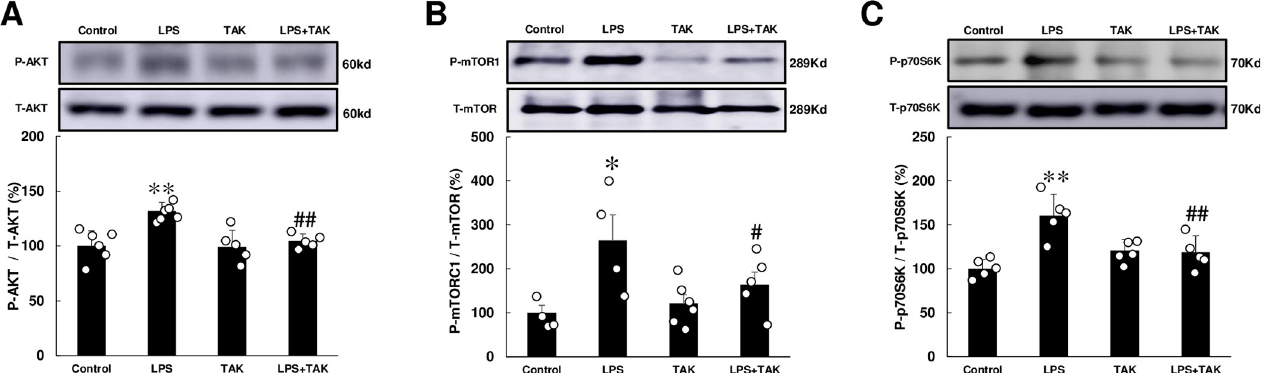
Fig 6. Effects of chronic PG-LPS infusion on Akt, mTOR, p70S6K, LC3, p62 in the heart. (A) Akt phosphorylation (Ser-473) was significantly increased in the PG-LPS group, and this increase was significantly attenuated by TAK-242. �� P < 0.01 vs. Control or ## P < 0.01 vs. PG-LPS group by one-way ANOVA followed by the Tukey-Kramer post hoc test. Full-size images of immunoblots are presented in S14 Fig of S1 Data. (B) mTORC1 phosphorylation (Ser-2448) was significantly increased in the PG-LPS group, and this increase was significantly attenuated by TAK-242. � P < 0.05 vs. Control or ## P < 0.05 vs. PG-LPS group by one-way ANOVA followed by the Tukey-Kramer post hoc test. Full-size images of immunoblots are presented in S15 Fig of S1 Data. (C) p70S6K phosphorylation (Ser-389) was significantly increased in the PG-LPS group, and this increase was significantly attenuated by TAK-242. �� P < 0.01 vs. Control or ## P < 0.01 vs. PG-LPS group by one-way ANOVA followed by the Tukey-Kramer post hoc test. Full-size images of immunoblots are presented in S16 Fig of S1 Data. Data shows means ± SD and scattered dots show individual data.